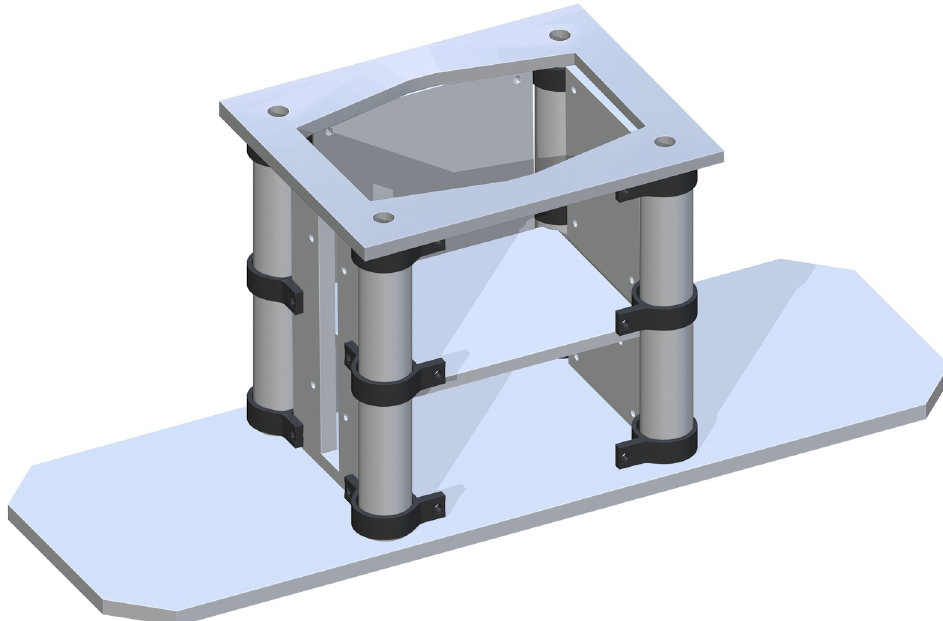
Fig 5. Addition of Jack top HDPE to center of base assembly.